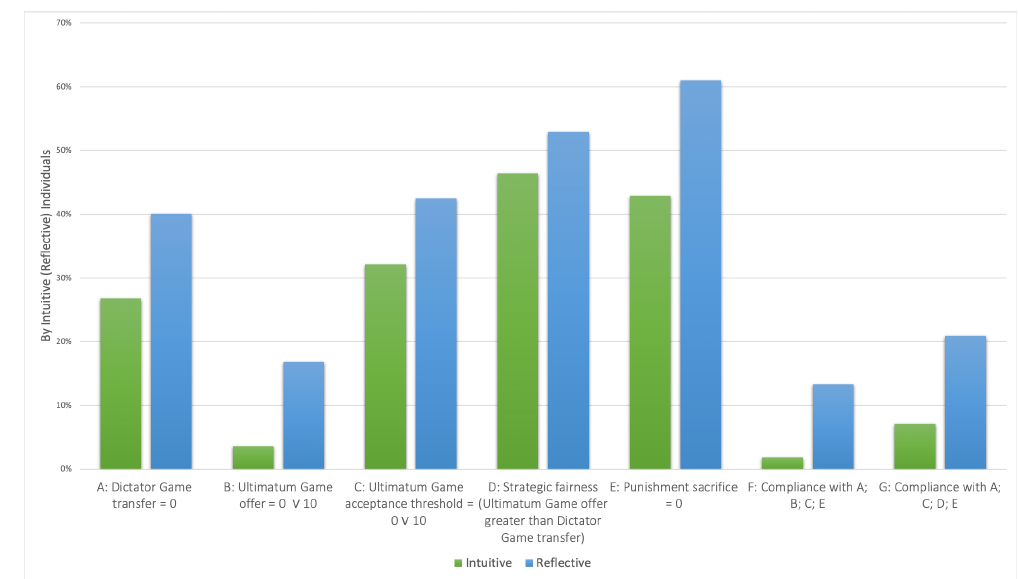
Figure A1. Frequency of Decision by Intuitive (Reflective) Individuals.